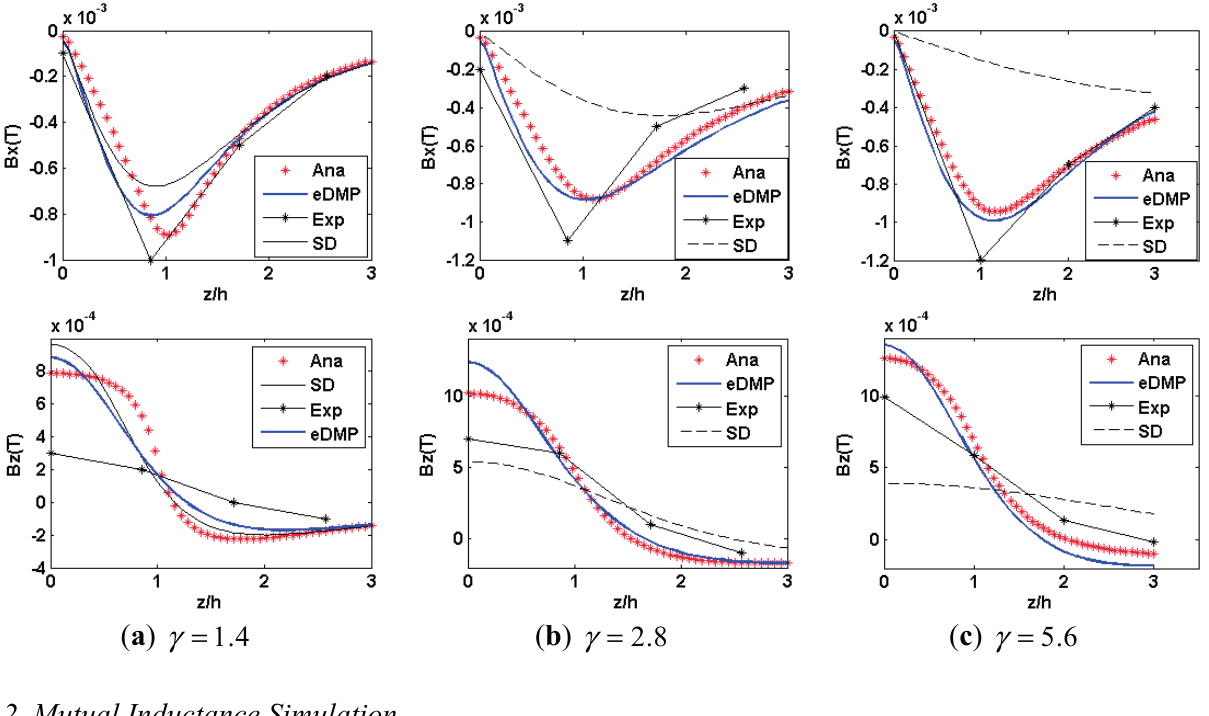
Figure 4. Simulation results of different aspect